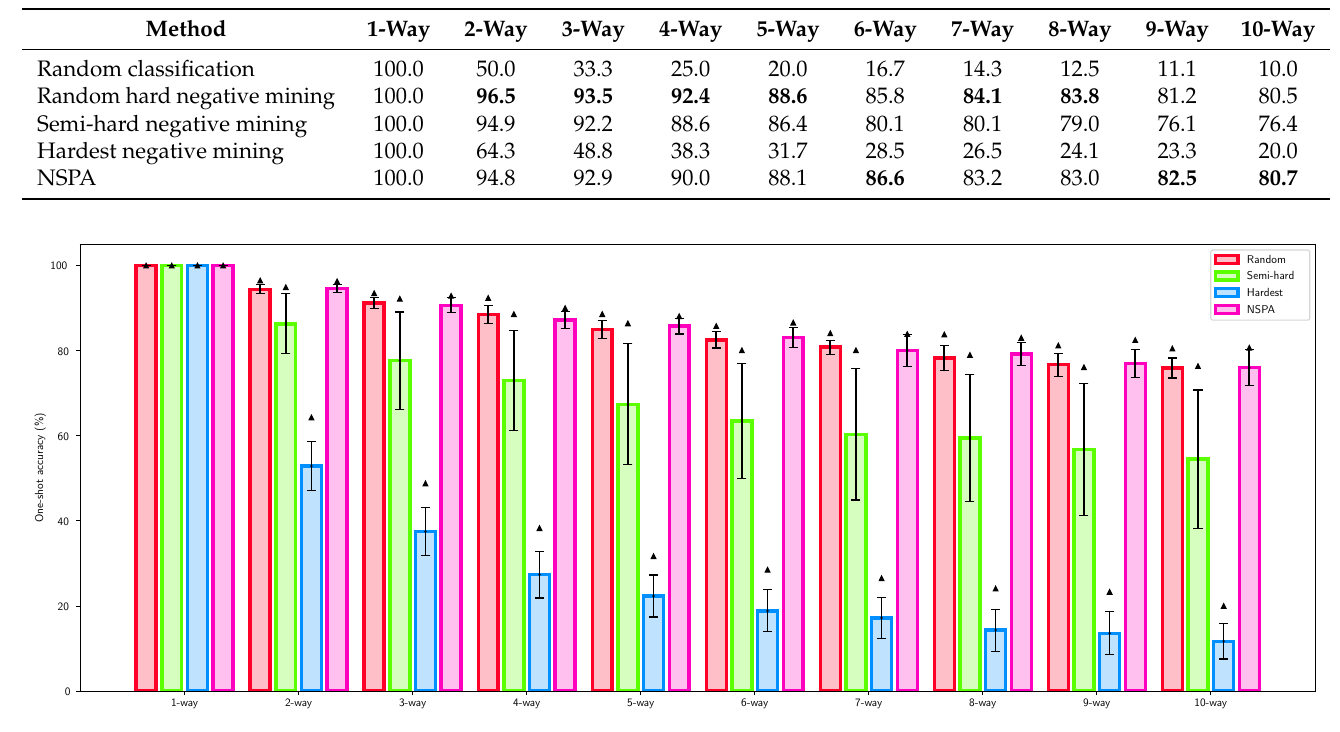
Figure 6. One-shot accuracy for n -way classification using different negative sampling techniques compared to the proposed NSPA algorithm. Error bars visualize the standard deviation of the performance of different models, while the triangle indicates the top